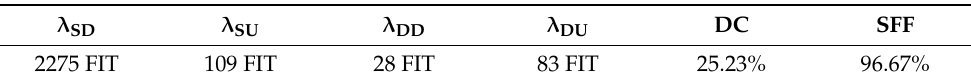
Table 3. Failure rates, DC (diagnostic coverage) and SFF (safe failure fraction) for the temperature sensor under